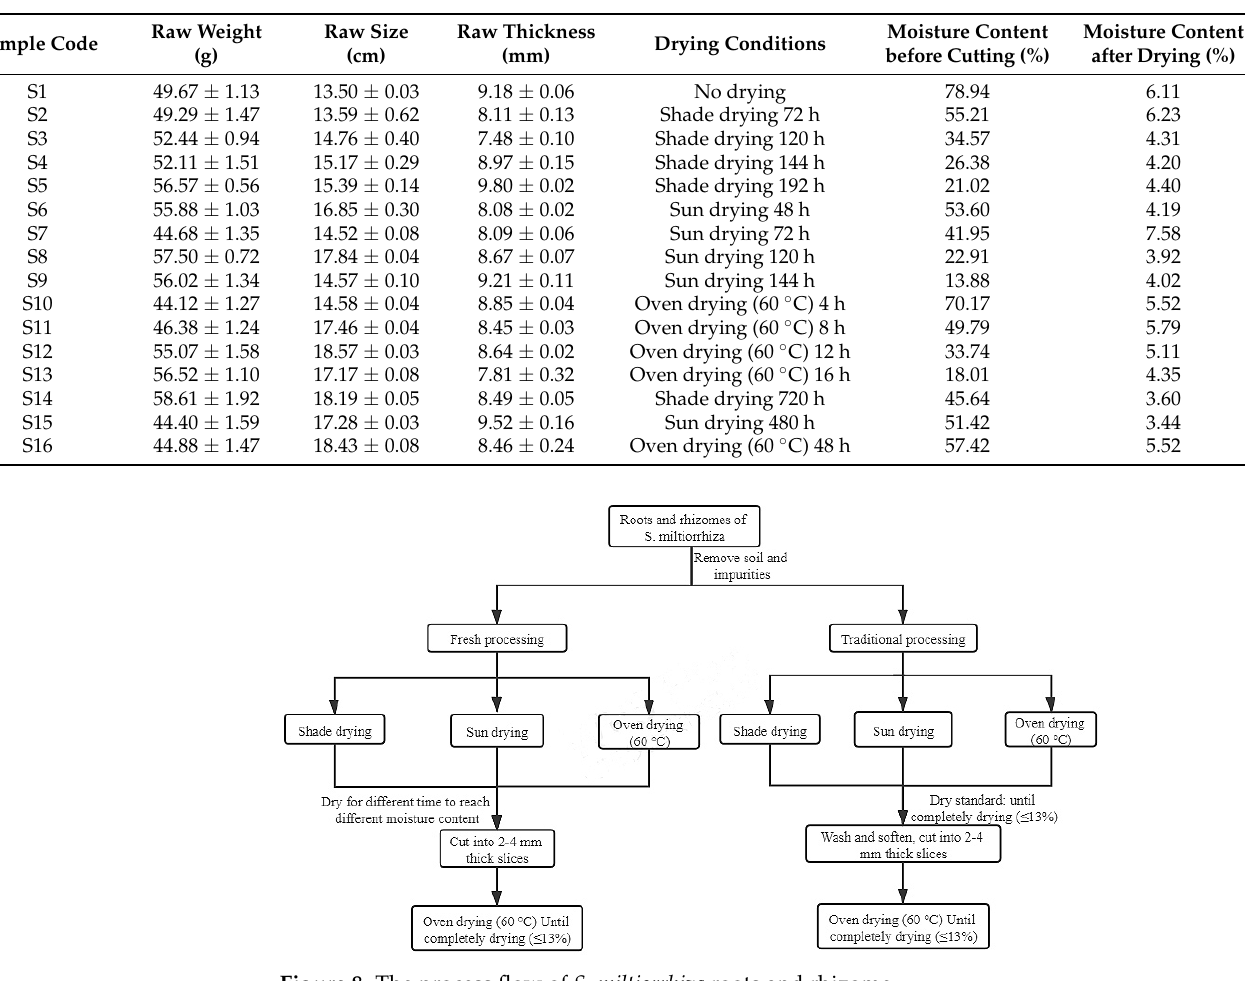
Figure 8. The process flow of S. miltiorrhiza roots and rhizome. Table 2. Different processing treatment methods.